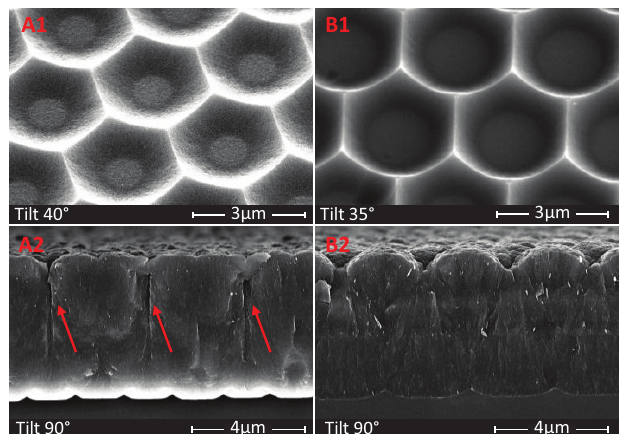
Fig. 8. SEM images of honeycomb structures. A1-2 have a honeycomb periodicity of 2 m m, while B1-2 have a periodicity of 3 m m. A1 and B1 are surface images at 35 – 40 ° tilt. A2-B2 are cross-sectional images of a c-Si honeycomb surface structure on top of which a 5 m m nc-Si layer is grown. Red arrows in image A2 indicate cracks formed in the nc-Si phase as a result of the honeycomb surface